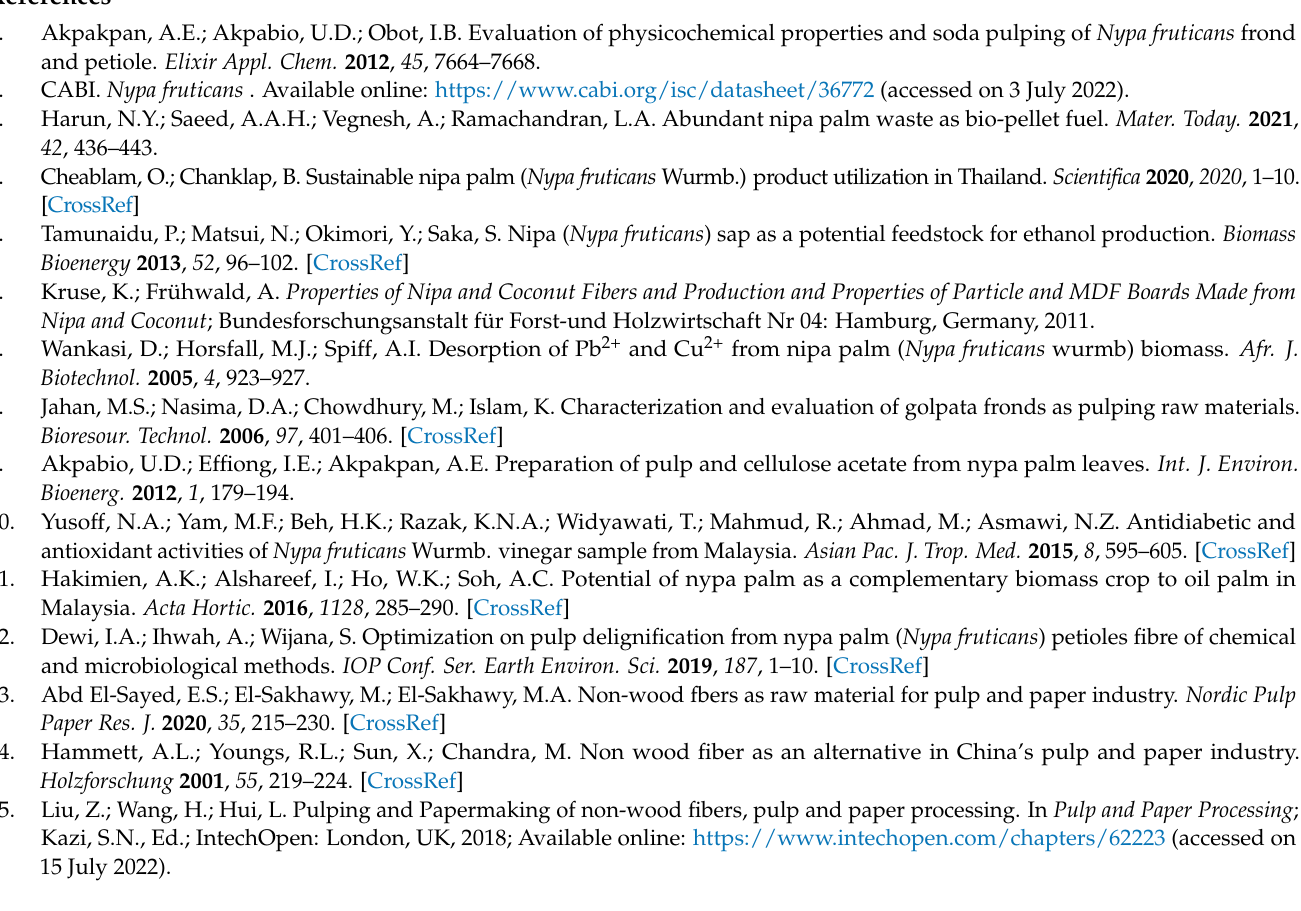
Figure A3. Charge oxygen gas under 0.35–0.50 MPa at room temperature.